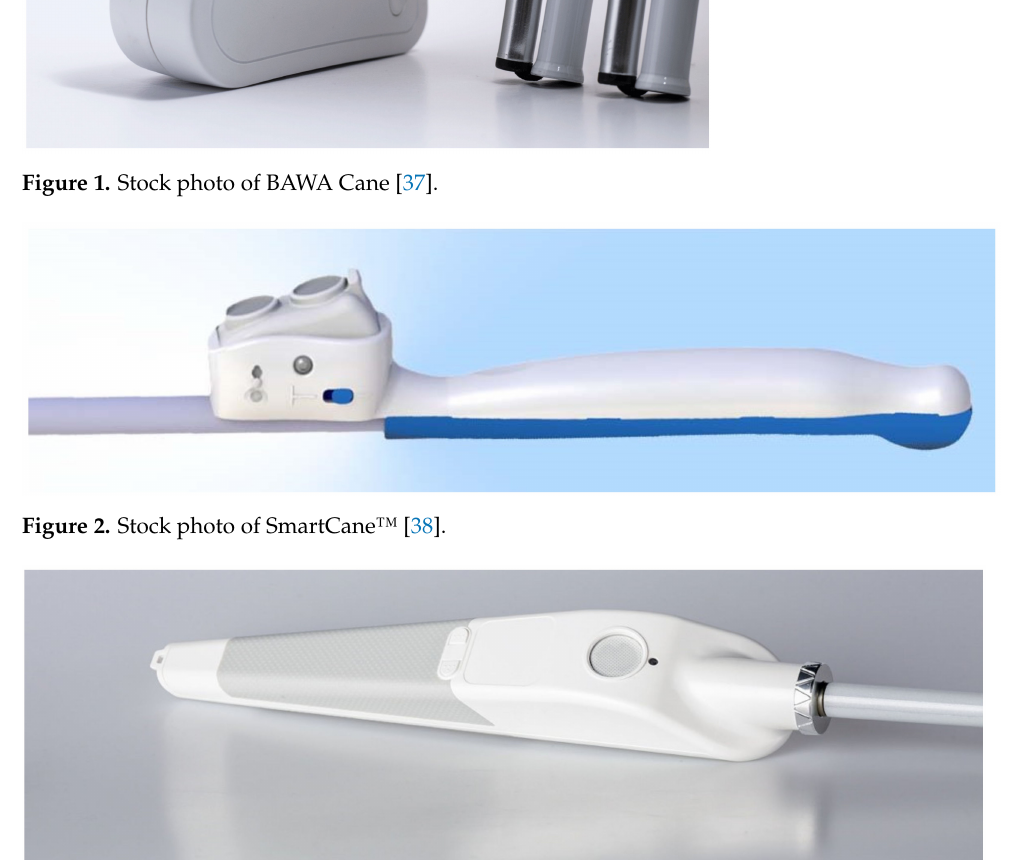
Figure 3. Stock photo of WeWalk Cane